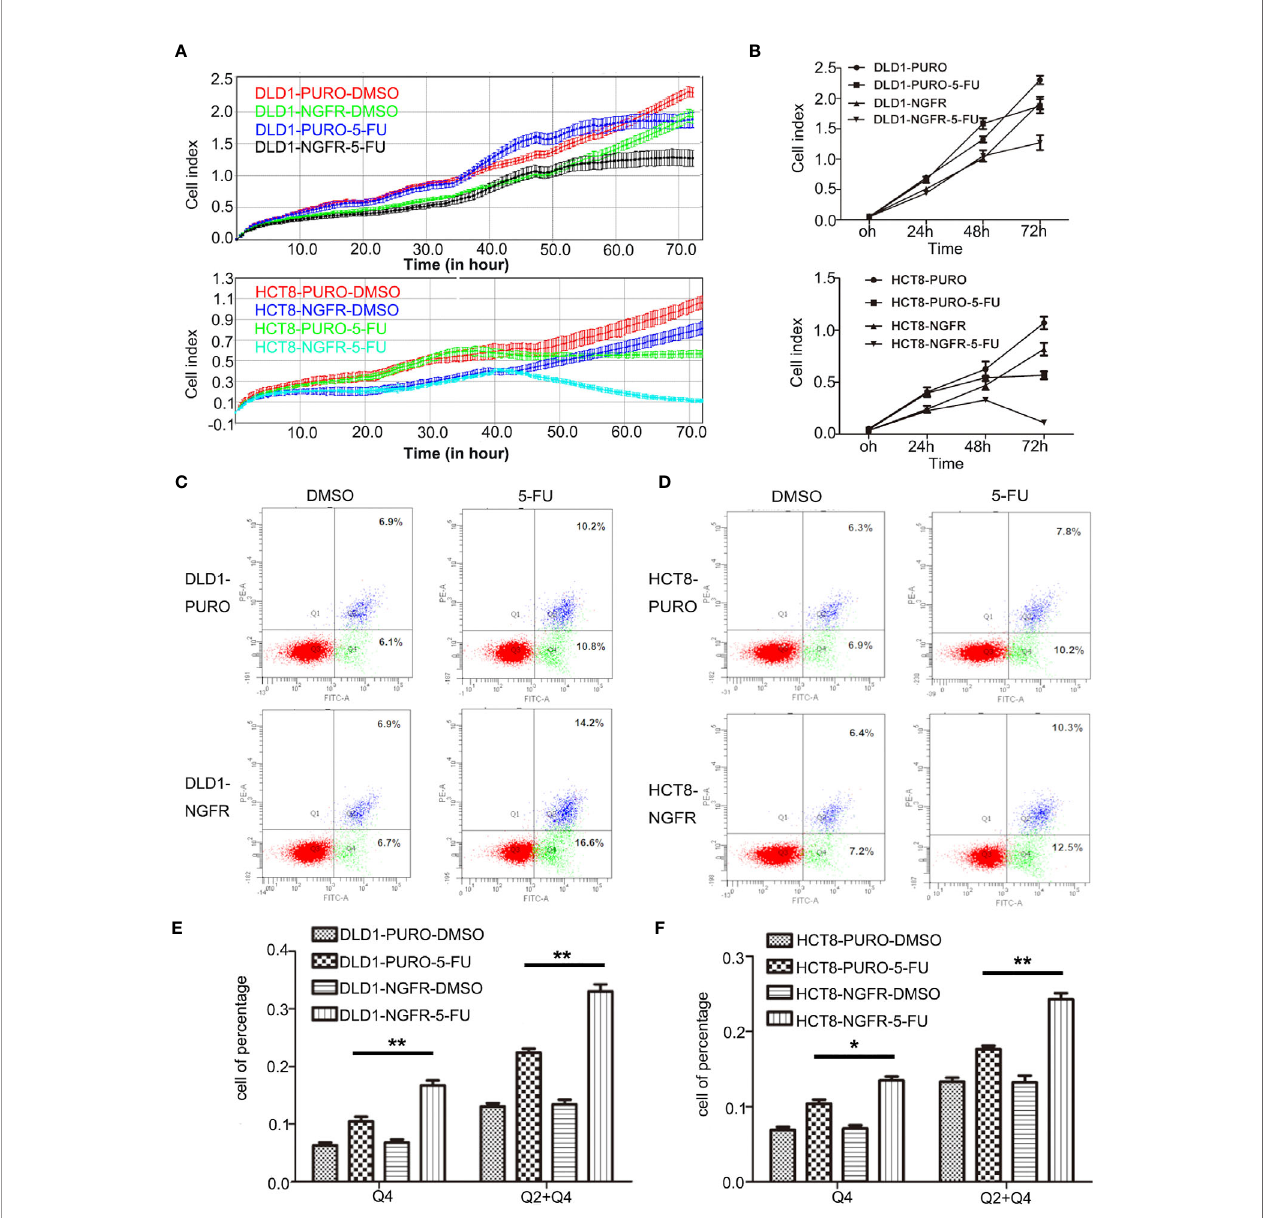
FIGURE 2 | NGFR increases the chemosensitivity of CRC cells to 5-FU by elevating 5-FU-induced apoptosis. (A, B) Real-time cellular analysis con fi rmed the results of the colony formation assays regarding the inhibition of overexpressed NGFR – transfected DLD1 and HCT8 cell growth with 5-FU treatment (t-test; P < 0.01 for DLD1 cells). Overexpressed NGFR – transfected (C) DLD1 and (D) HCT8 cells treated with 5-FU for 48 h. Cell apoptosis was quantitated on the graph using an Annexin V:PE apoptosis detection kit and a fl ow cytometer. The apoptosis rate was signi fi cantly increased in overexpressed NGFR – transfected (E) DLD1 and (F) HCT8 cells after 5-FU treatment (Q4, early apoptosis; Q2 + Q4, total apoptosis; t-test; P < 0.01 for DLD1 cells, P < 0.01 for HCT8 total apoptosis cells, P < 0.05 for HCT8 early apoptosis cells). *P < 0.05; **P <